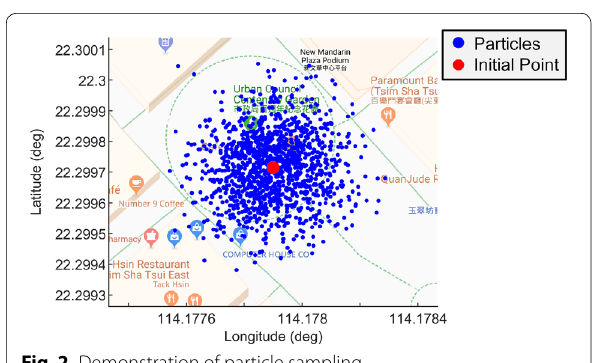
Fig. 2 Demonstration of particle sampling